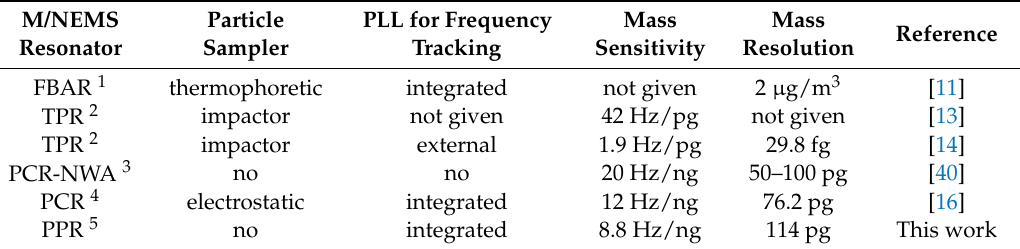
Table 1. M/NEMS-based resonators for gravimetric cigarette smoke